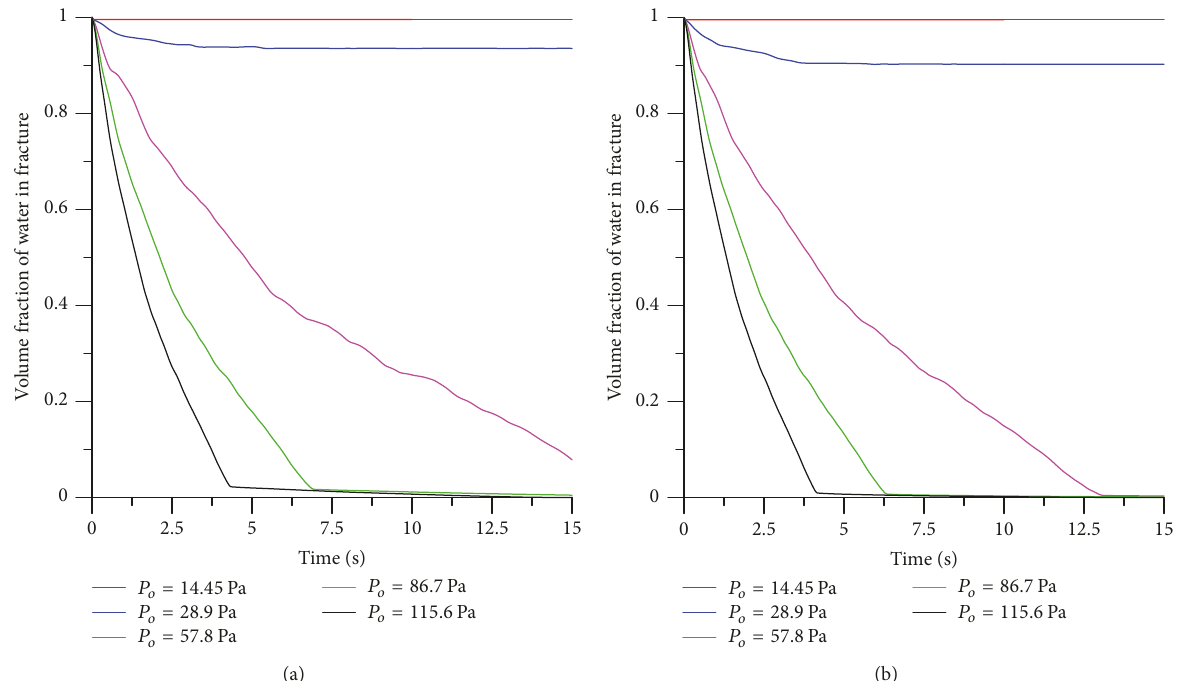
Figure 13: Volume fraction of water in the fracture for different wettability setting of the fracture wall: (a) FD = 2.2, contact angle 30 ∘ ; (b) FD = 2.2, contact angle 60 ∘ .